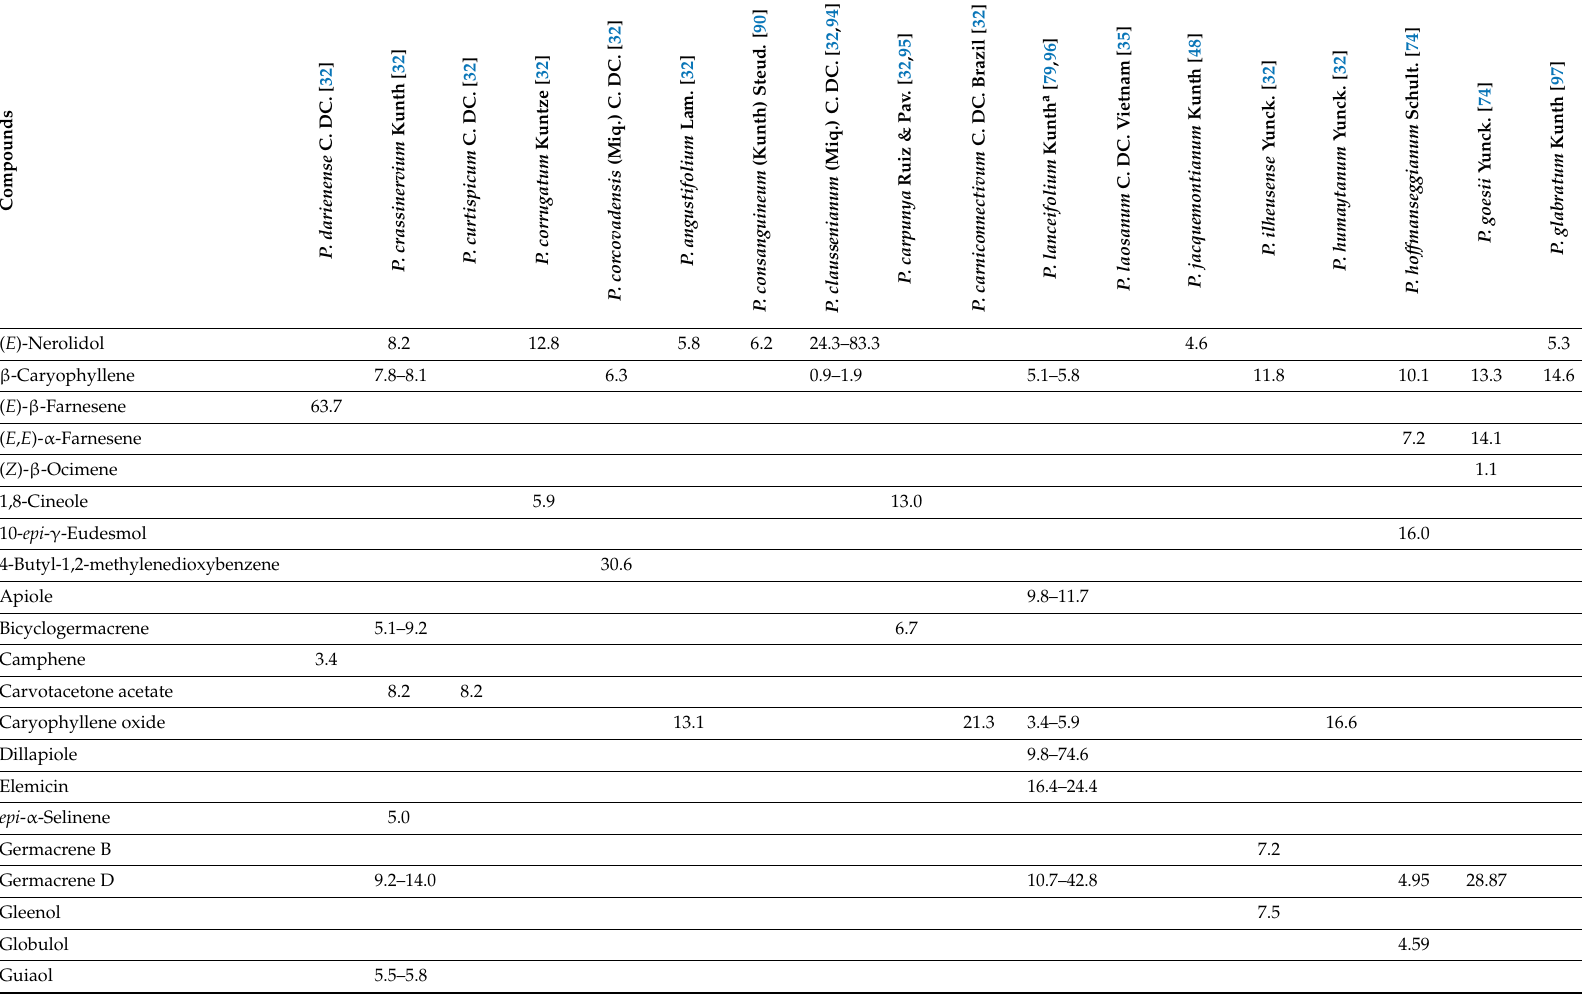
Table 23. Chemical compositions (%) of leaf essential oils from miscellaneous Piper species, part